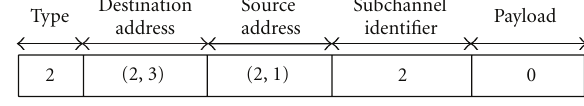
Figure 8: Set-up packet node source (2,1).